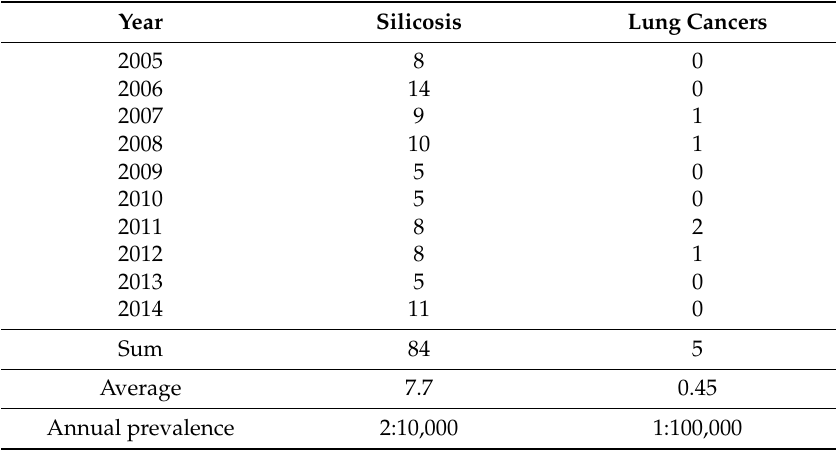
Table 3. The number of occupational diseases from respirable quartz exposure per year